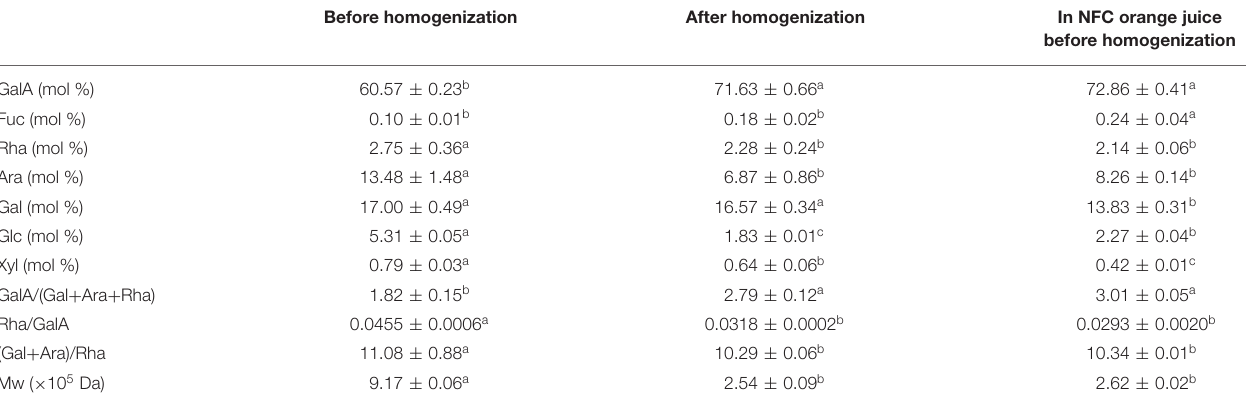
TABLE 2 | Pectin structure properties (Mw and monosaccharide composition) after homogenization (100 MPa). Before homogenization